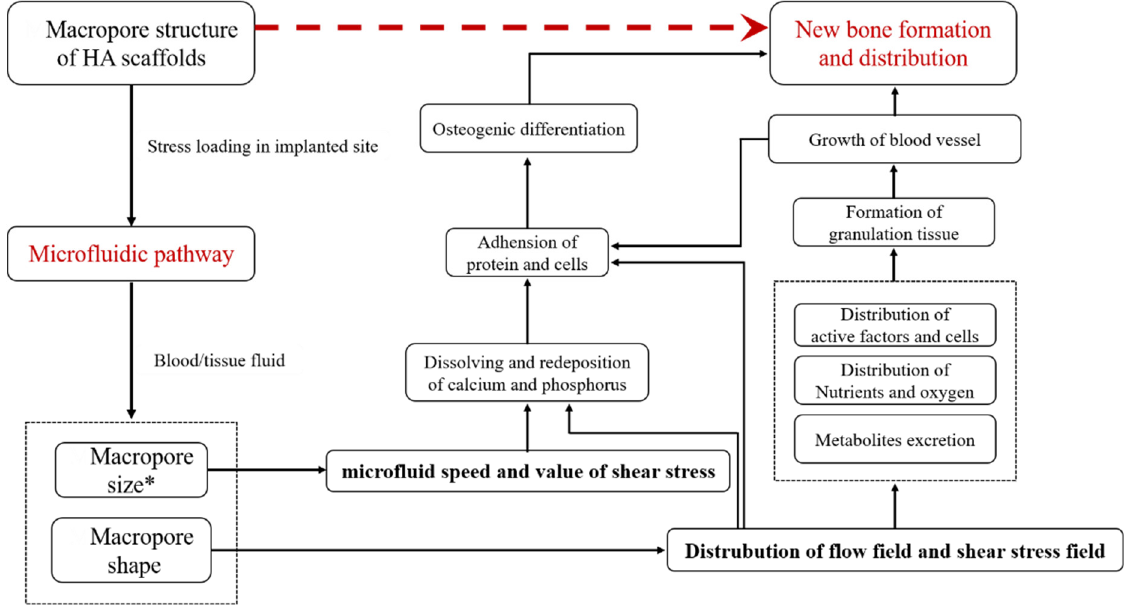
Figure 7. The osteoinductive mechanism of macropore structure of HA scaffolds.